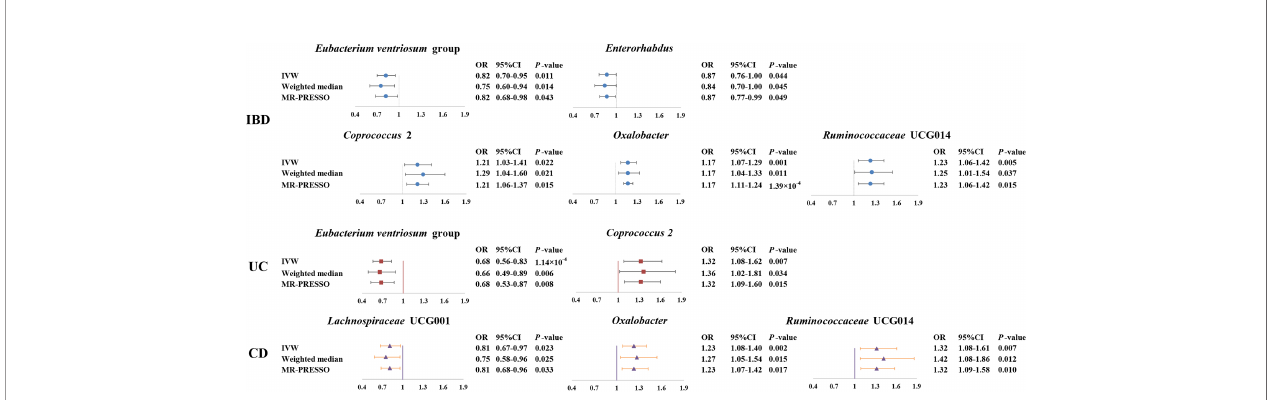
FIGURE 3 | Forest plot of the associations between genetically determined six gut microbial genera with the risks of IBD, UC, or CD. Presented are the gut microbiota genera that were statistically signi fi cant across all analyses (IVW, weighted median, MR-PROSSE). Abbreviations: CD, Crohn ’ s disease; CI, con fi dence interval; IBD, in fl ammatory bowel disease; IVW, inverse-variance weighted; MR-PRESSO, Mendelian Randomization Pleiotropy RESidual Sum and Outlier; OR, odds ratio; UC,